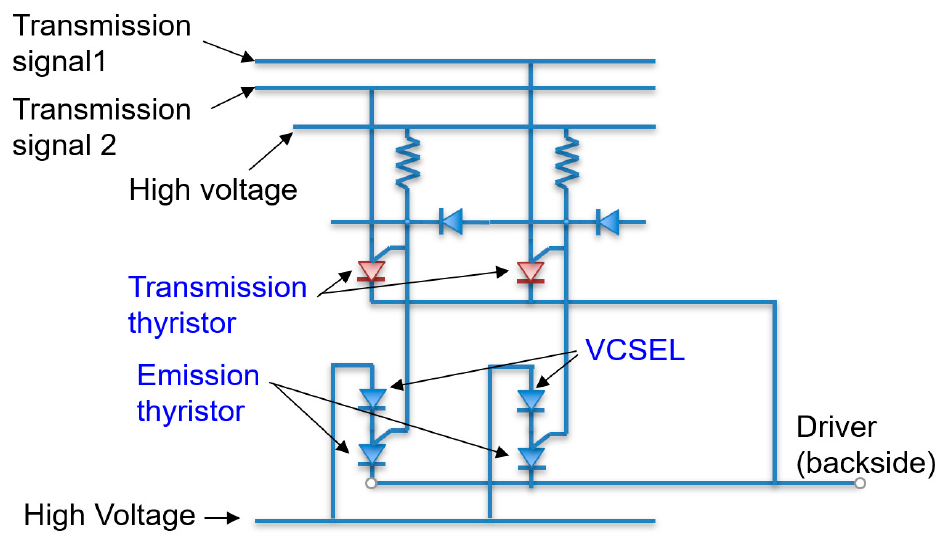
Figure 3. Equivalent circuit of the proposed SS-VCSEL.